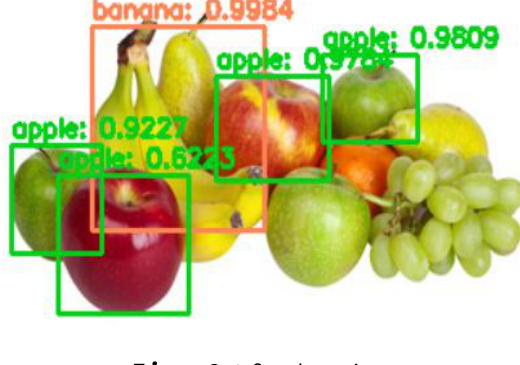
Figure 9. After detection.